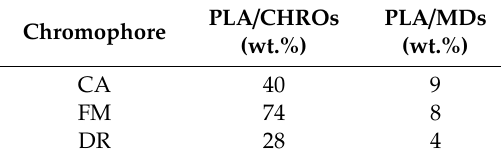
PLA / CHROs PLA / Chromophore (wt.%)